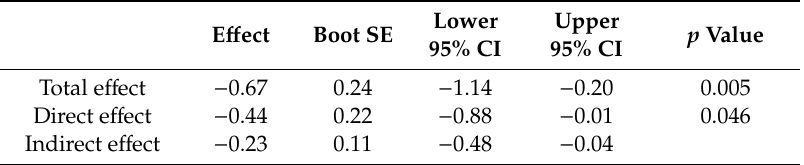
Figure 3. Mediation model tested. The relation between co-consumption and GPA was mediated by academic adjustment (* p < 0.05, *** p < 0.001). C / BDCA: Control vs. BDCA. Table 3. Relative total, direct and indirect effects of alcohol/cannabis use on GPA mediated by academic adjustment.